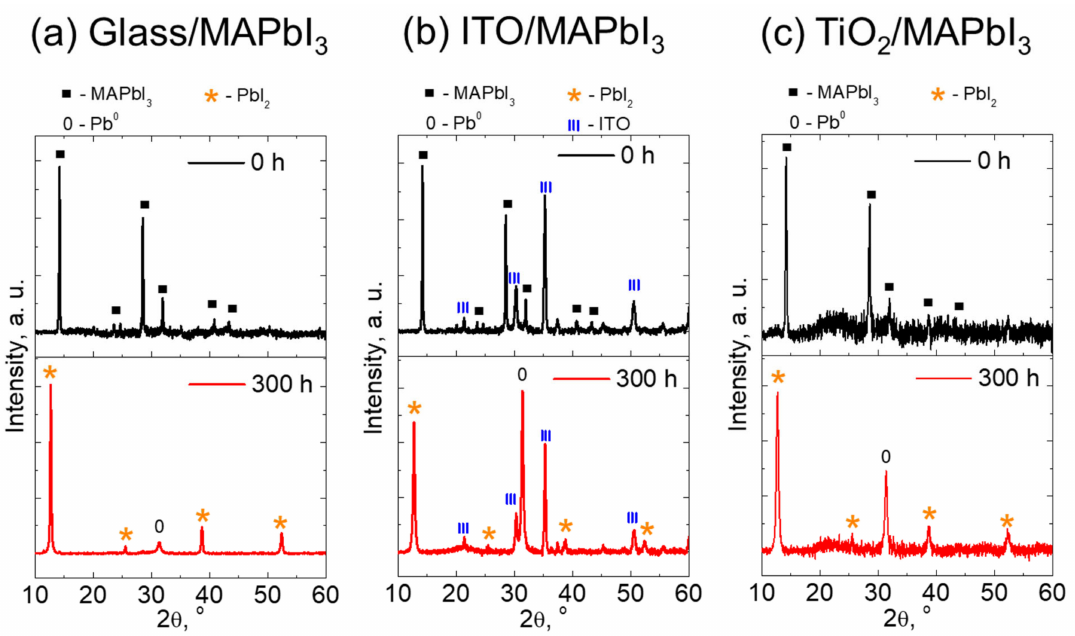
Figure 3. XRD patterns of MAPbI 3 films grown on ( a ) glass, ( b ) ITO, and ( c ) TiO 2 substrates before and after 300 h of light soaking.